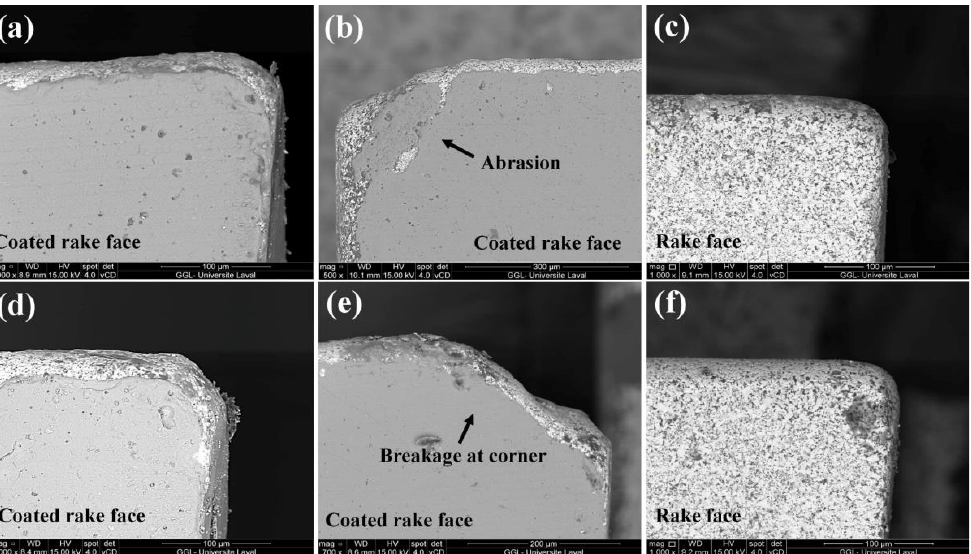
Figure 23. SEM micrographs of the corners of the tips (rake face view): ( a – c ) saws #2, 4, and 6, respectively after 480 min of sawing and ( d – f ) saws #2, 4, and 6, respectively after 960 min of sawing. Representative SEM micrographs of the cutting edge after 480 min of sawing are pre-